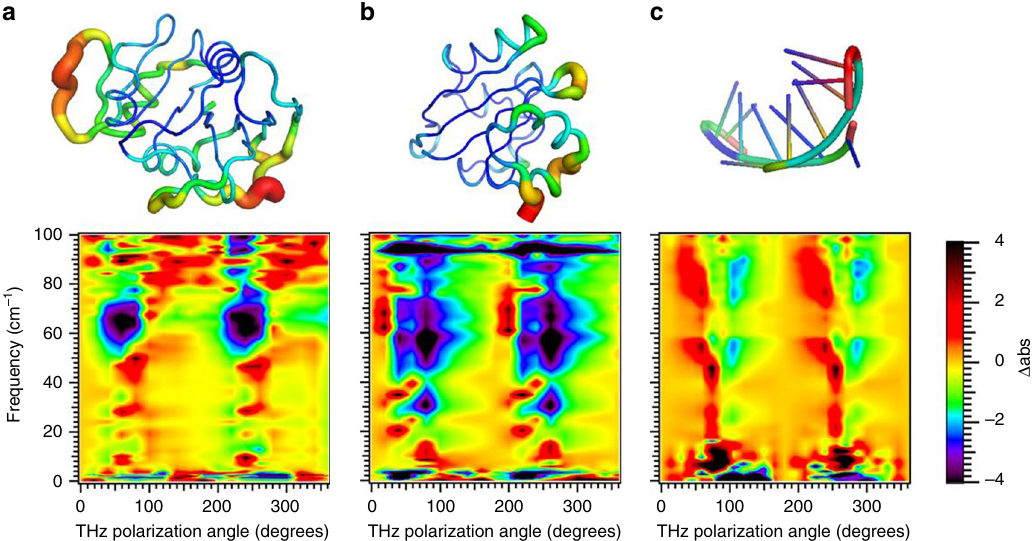
Fig. 5 Unique dynamical fi ngerprints for different biomacromolecules. PV-ATM spectra for a E. coli DHFR (1dra.pdb); b photoactive yellow protein (2phy. pdb) and c RNA G-quadruplex (4xk0.pdb) rendered with Pymol B-factor putty. B-factor varies from high (red) to low (blue). While the vibrational density of states, that is the vibrational energy spectrum, for the three systems are highly similar, the actual motion for a given vibrational energy is structure speci fi c leading to large differences in the anisotropic